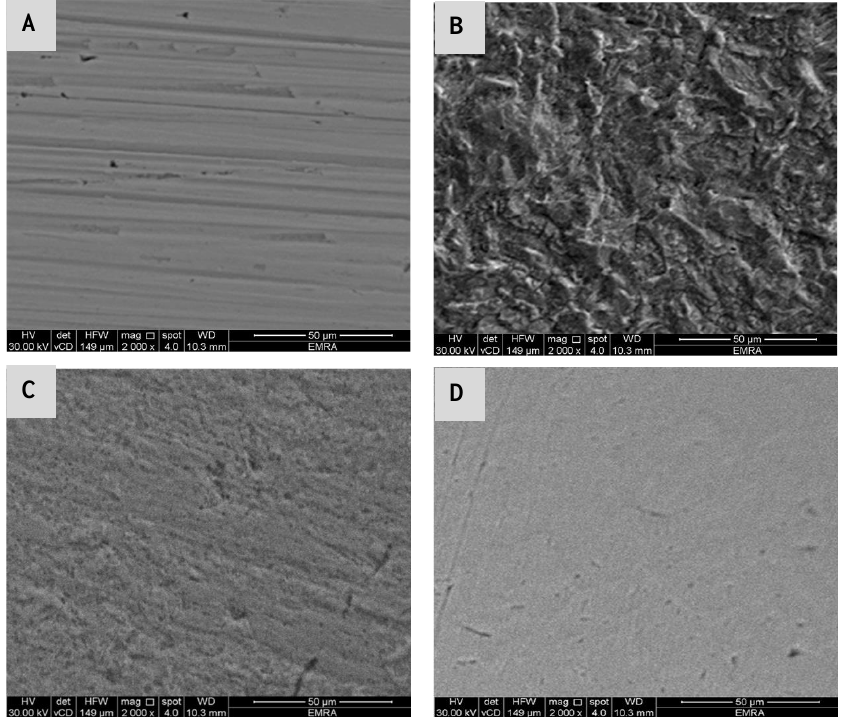
Figure 11. FESEM pictures of ( A ) pristine X60 ‐ steel, ( B ) uncoated X60 ‐ steel dipped in 15% HCl after 24 h, ( C ) X60 ‐ steel coated with 1% CeO 2 @gelatin dipped in 15% HCl after 24 h, and ( D ) X60 ‐ steel coated with 5% CeO 2 @gelatin dipped in 15% HCl after 24 h.